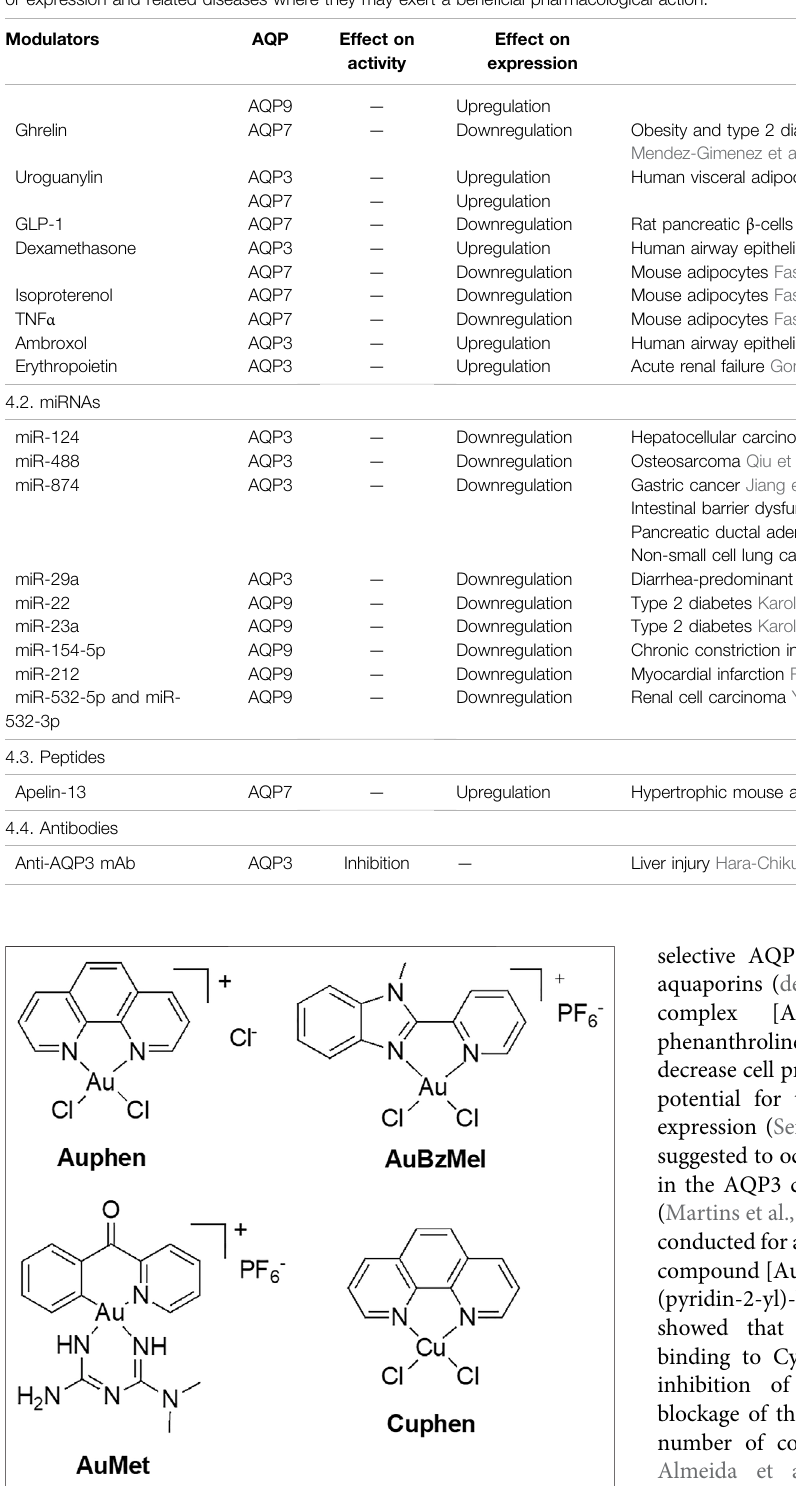
TABLE 1 | ( Continued ) Classes of compounds (transition metal compounds, smallmolecules, natural compounds and biologicals) modulators of aquaglyceroporin function or expression and related diseases where they may exert a bene fi cial pharmacological action.